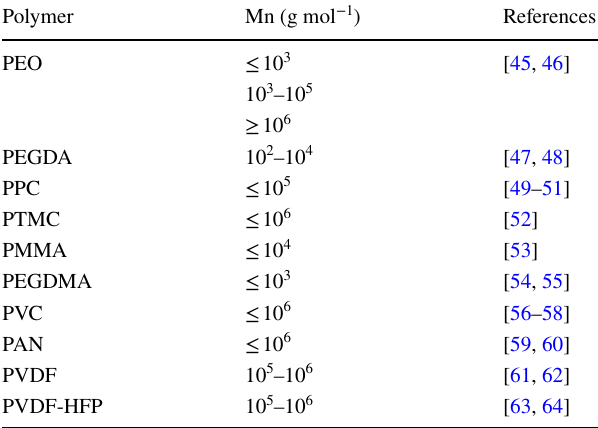
Table 1 The molecular weight of common polymers